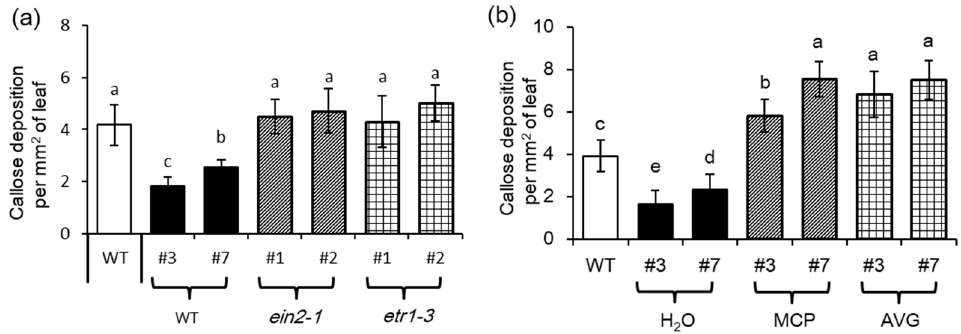
Figure 9. ET signaling is required for inhibiting callose accumulation by overexpression of MYB102. ( a ) Callose deposition in leaves of WT, MYB102-OX lines, MYB102-OX / ein2–1 , and MYB102-OX / etr1– 3 ( n = 10) after 48 h of aphid infestation. ( b ) Callose deposition in leaves of WT and MYB102-OX lines with or without treatments with 1-methylcyclopropene (MCP) or aminoethoxyvinyl glycine (AVG). Different letters above bars denotes significant difference among different treatments using Tukey’s test at p < 0.05.